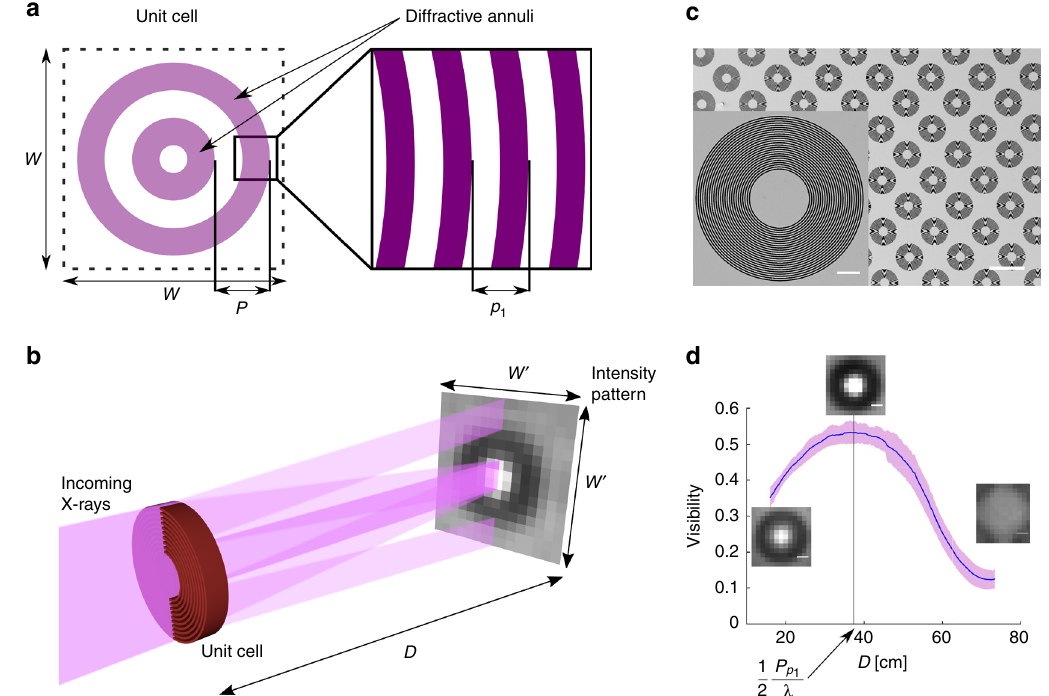
Fig. 1 Fringe formation for a single unit cell. a Schematic of a single unit cell containing two diffractive annuli. b The periodic substructure of the annulus causes diffraction of the incoming X-rays. Given suf fi cient propagation the ± 1 diffraction orders have split and superimpose incoherently with the opposite orders generating the shown intensity modulation pattern. c Fabricated grating for 17 keV containing one diffractive annulus of 50 μ m period and 1 μ m diffractive substructure, the scale bars for the inset and the overview image are 10 and 100 μ m , respectively. d Measured visibility for the grating in c in Pp 1 dependency on the propagation distance D . The maximum visibility is observed at a distance of 1 λ independently of the type of the diffractive structure. 2 The insets represented the fringe from a single unit cell at the given distances. The scale bars correspond to 20 μ m . The width of the band corresponds to six times the observed standard deviation over the full fi eld of view